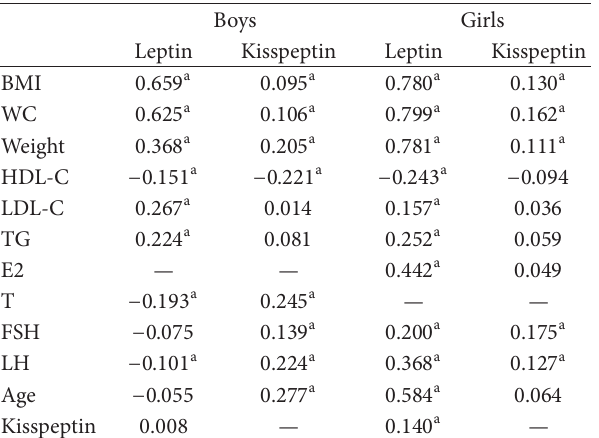
Table 3: Regression analysis of serum leptin and kisspeptin levels with other clinical